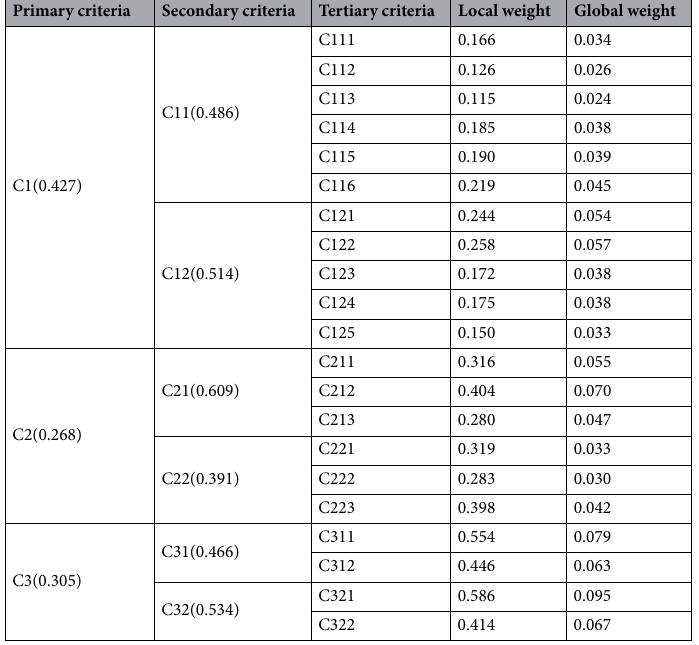
Table 6. Local and global weights for consumer drone design concept evaluation criteria.